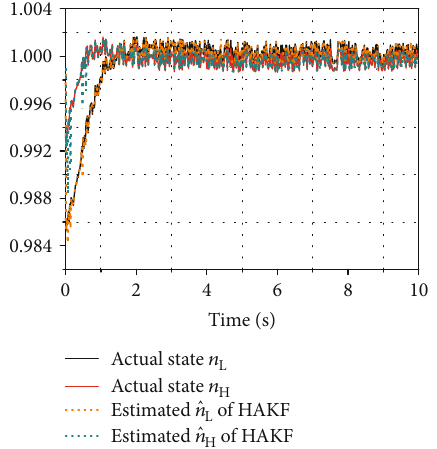
Figure 17: Measurements and their reconstructed values.